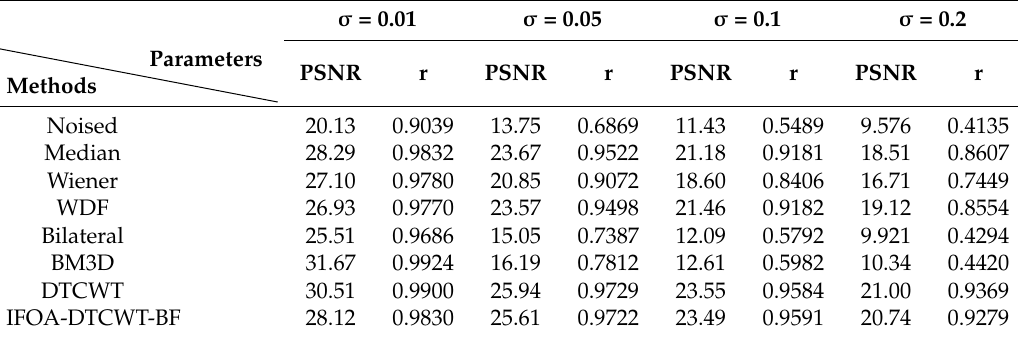
Table 4. Comparison of the five methods (Peppers with Gaussian noise).